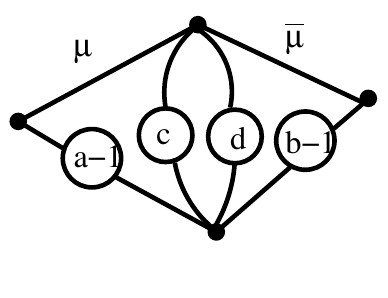
Figure 12 . B ( a; b ; c; d ).